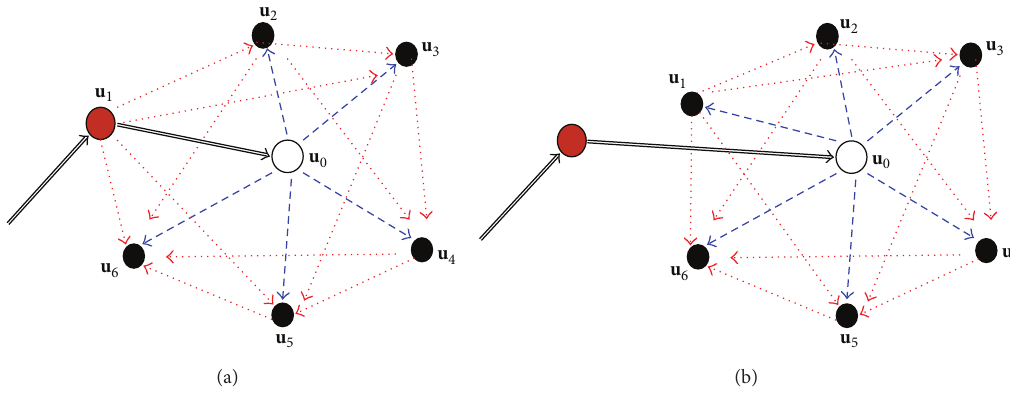
Figure 1: Neighborhood structures with six nearest neighbors and the sequential Bayesian updating process in basic Markov chain random fields: (a) assuming u 1 to be the last visited location; (b) assuming the last visited location is far away (outside the neighborhood). Data interactions across the uninformed location u 0 being estimated are ignored according to the Markov